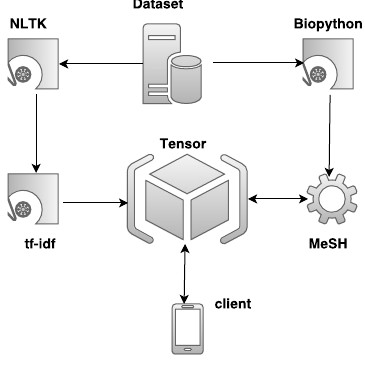
Figure 1. System